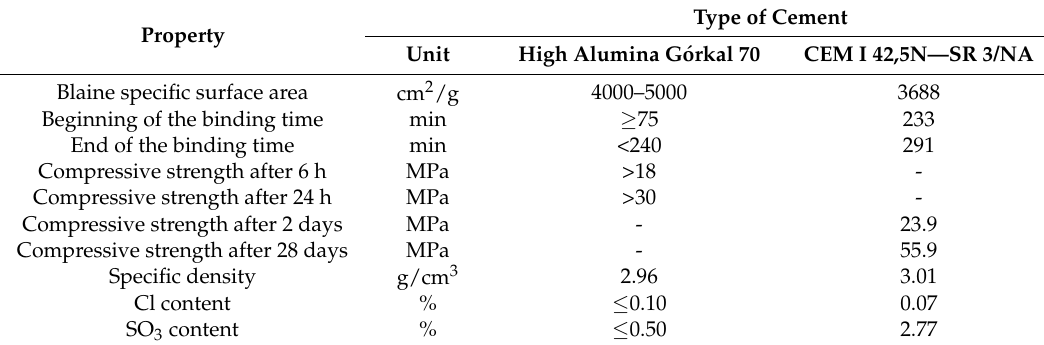
Table 4. Basic properties of the cements used to manufacture the tested concretes.